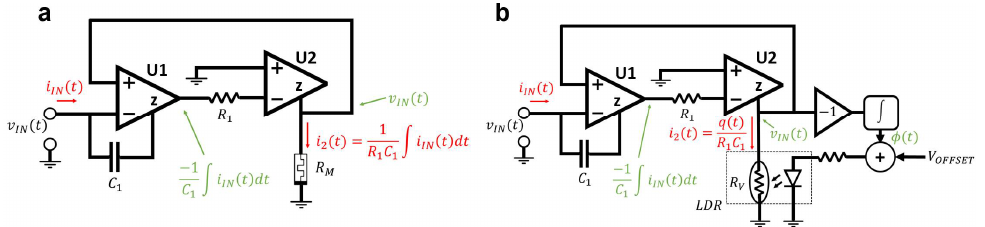
Figure 5. ( a ) Memcapacitor emulator circuit proposed by Wang et al. [44] implemented with a voltage-controlled memristor. ( b ) Memcapacitor emulator schematic using a memristor emulator based on a LED optically coupled to a LDR (light-dependent resistor).